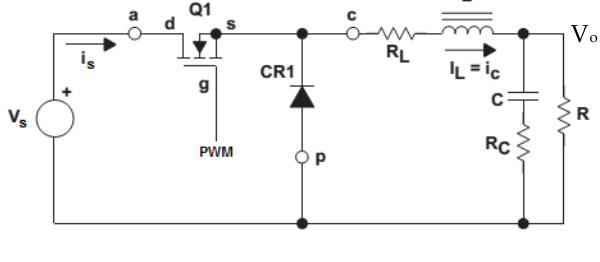
Figure 3. Buck converter circuit.